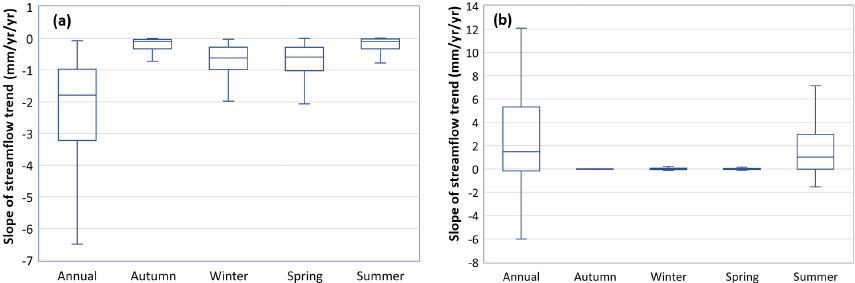
Figure 4. Box plot of the Theil–Sen slope in millimetres per year per year for annual and seasonal streamflow for drainage divisions in (a) southern and (b) northern Australia.